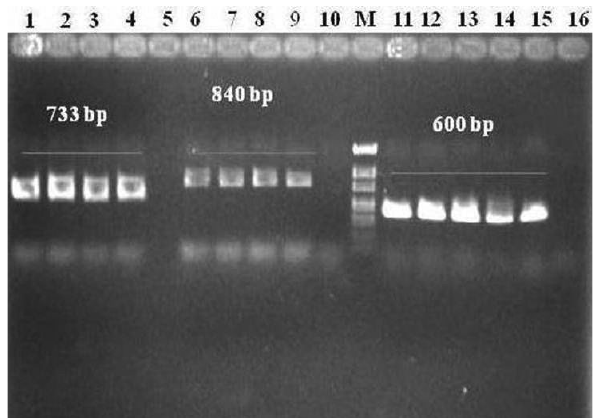
Figure 3. Gel electrophoresis pattern of PCR amplification products using Xylella fastidiosa specific primers. PCR products with primers RST31/RST33 from bacterial colonies isolated from pistachio (lane 1), from pistachio petioles (lane 2), from bacterial colonies isolated from grape (positive control, lane 3), from bacterial colonies iso- lated from almond (positive control, lane 4), from healthy pistachio petioles (negative control, lane 5). PCR products with primers Dix- on454fa/Dixon1261rg from bacterial colony isolated from pistachio (lane 6), from pistachio petioles (lanes 7 and 8), from bacterial col- onies isolated from almond (positive control, lane 9), from bacterial colonies isolated from grape (negative control, lane 10). PCR prod- ucts with primers 272-1-int/272-2-int from bacterial colonies iso- lated from pistachio (lane 11), from pistachio petioles (lanes 12 and 13), from bacterial colonies isolated from almond (positive control, lane 14), from bacterial colonies isolated from grape (positive con- trol, lane 15), from healthy pistachio petioles (negative control, lane 16). 100 bp DNA ladder (lane M).